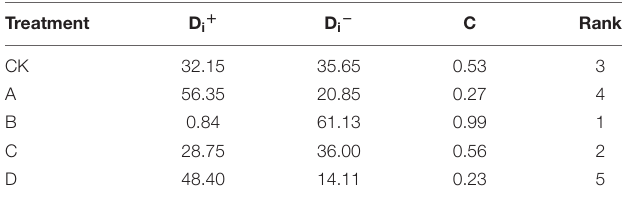
TABLE 2 | Technique for Order of Preference by Similarity to Ideal Solution (TOPSIS) analysis of different treatments of based on 15 indicators on storage day